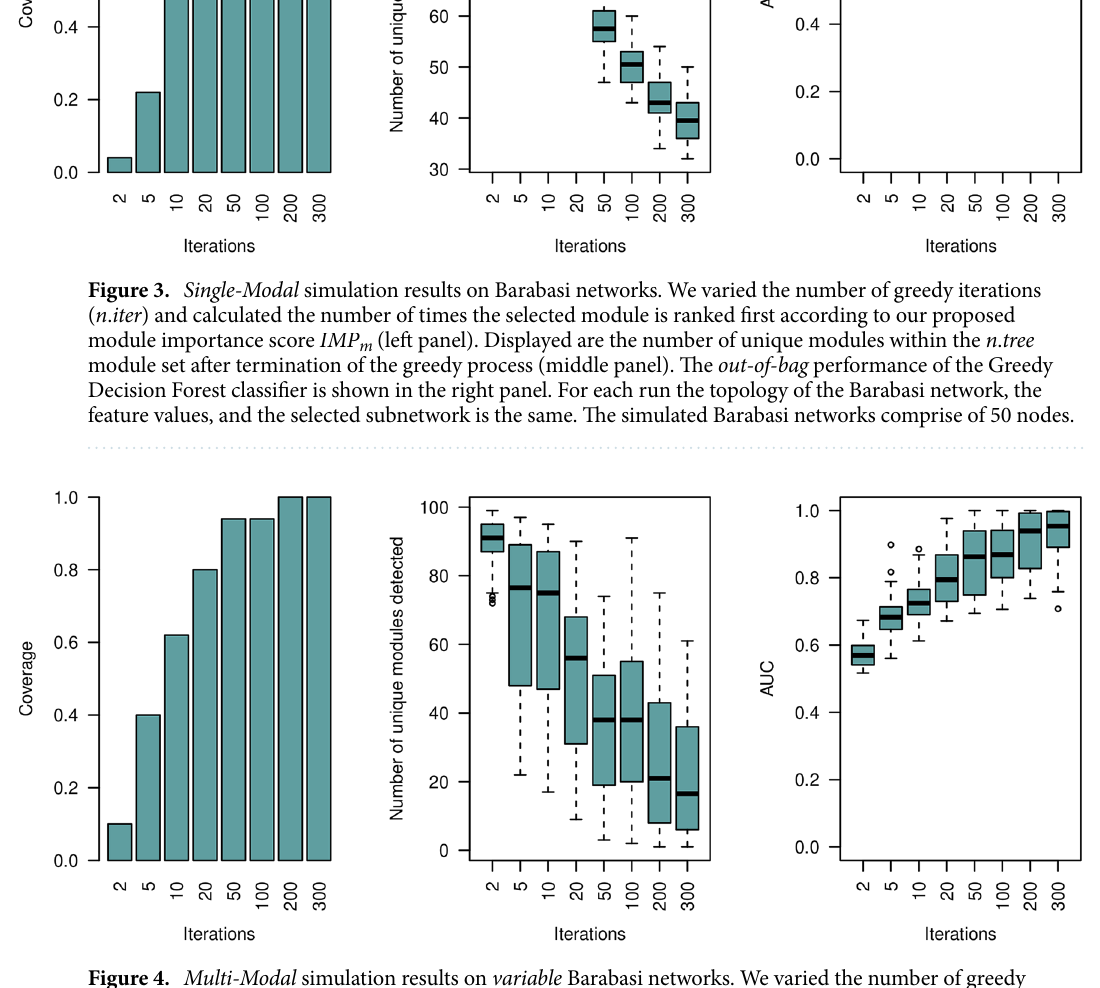
Figure 4. Multi-Modal simulation results on variable Barabasi networks. We varied the number of greedy iterations ( n . iter ) and calculated the number of times the selected module is ranked first according to our proposed module importance score IMP m (left panel). Displayed are the number of unique modules within the n . tree module set after termination of the greedy process (middle panel). The out-of-bag performance of the Greedy Decision Forest classifier is shown in the right panel. For each run the topology of the Barabasi network, the feature values, and the selected subnetwork varies . The simulated Barabasi networks comprise of 50